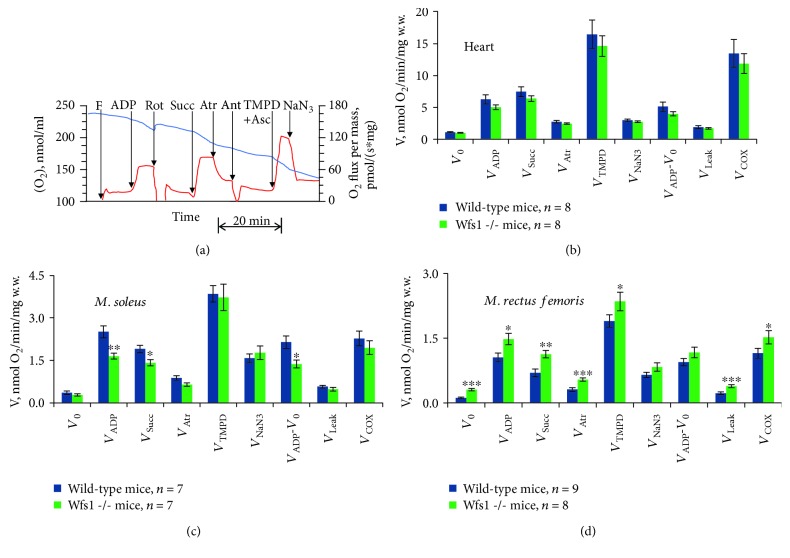
(a) Original recording of the assessment of the respiratory chain function in skinned muscle fibers. Additions: F: fibers; ADP: 2 mM ADP; Rot: 10 μM rotenone; Succ: 10 mM succinate; Atr: 0.1 mM atractyloside; Ant: 10 μM antimycin A; TMPD + Asc: 0.5 mM TMPD with 2 mM ascorbate; NaN3: 5 mM sodium azide. Upper, blue line: [O2]; lower, red line: O2 flux. Summary of results, which correspond to the experimental scheme shown in (a), is given in groups of permeabilized muscle fibers from the heart (b), musculus soleus (c), and musculus rectus femoris (d). V
0: basal respiration; V
ADP: complex I- and ADP-dependent respirations; V
Succ: complex II-dependent respiration in the presence of rotenone with succinate; V
Atr: atractyloside-insensitive respiration rate; V
TMPD: respiration with TMPD and ascorbate in the presence of antimycin A; V
NaN3: respiration in the presence of sodium azide; V
Leak: the difference between V
Atr and V
Ant, proton leak-dependent respiration; V
COX: sodium azide-sensitive portion of the respiration rate in the presence of TMPD and ascorbate. Data are mean ± SEM. Compared to wild type: ∗
P < 0.05, ∗∗
P < 0.01, and ∗∗∗
P < 0.001.